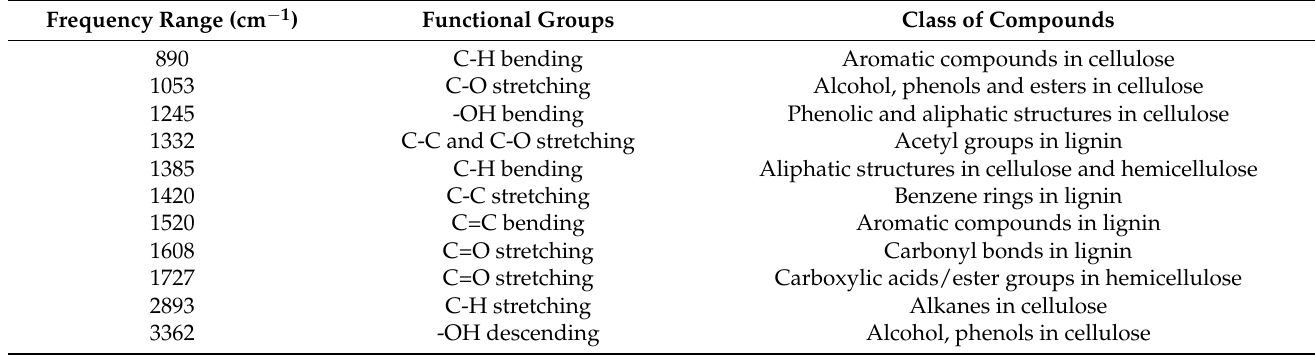
Figure 2. FT-IR spectra ( A ) and SEM images ( B ) of untreated and pretreated corncob. The SEM pic- tures of a1, b1, c1, a3, b3, c3, a5, b5, and c5 are at 1000×. Others are at 5000×. DLC(sa)-CC with 0.075 g sulfuric acid/g corncob was autoclave treated at 121 °C for 30 min and 25% solid loading, resulting in DLCA(sa)-CC. DLC(sa): densifying lignocellulosic biomass with sulfuric acid; DLC(sa)-CC: corn- cob pretreated by DLC(sa) method. DLCA(sa)-CC: corncob pretreated by DLCA(sa) method. Table 1. Infrared spectrums for functional groups present in different components of corn cob [24,25].